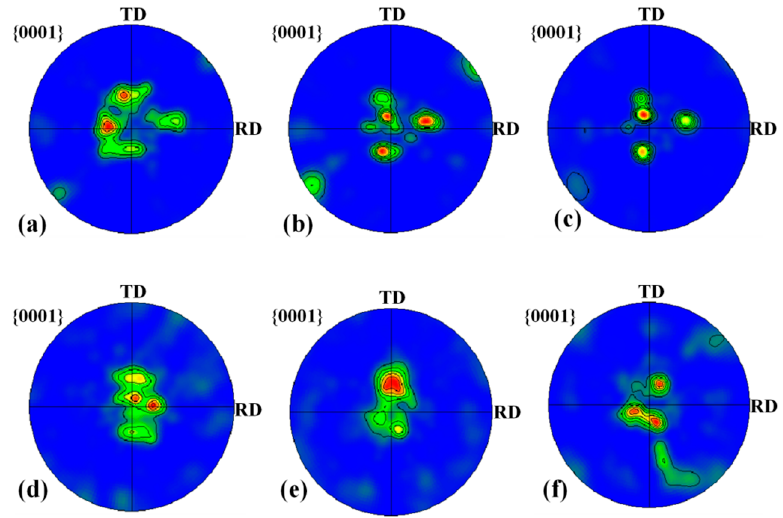
Figure 23. Pole figures for titanium calculated using the Channel 5 software for subdomains near the interface. ( a ) Ti-1; ( b ) Ti-2; ( c ) Ti-3; ( d ) Ti-I; ( e ) Ti-II; ( f ) Ti-III. Table 4. Main slip and twin systems of commercially pure titanium [21].